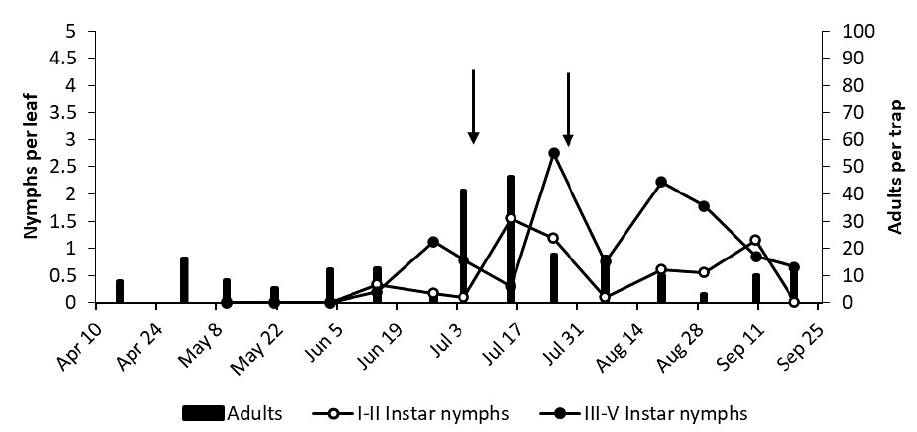
Figure 9. The phenology of E. vulnerata in LO1 vineyard in the growing season of 2019. Arrows indicate pyrethrins treatments.